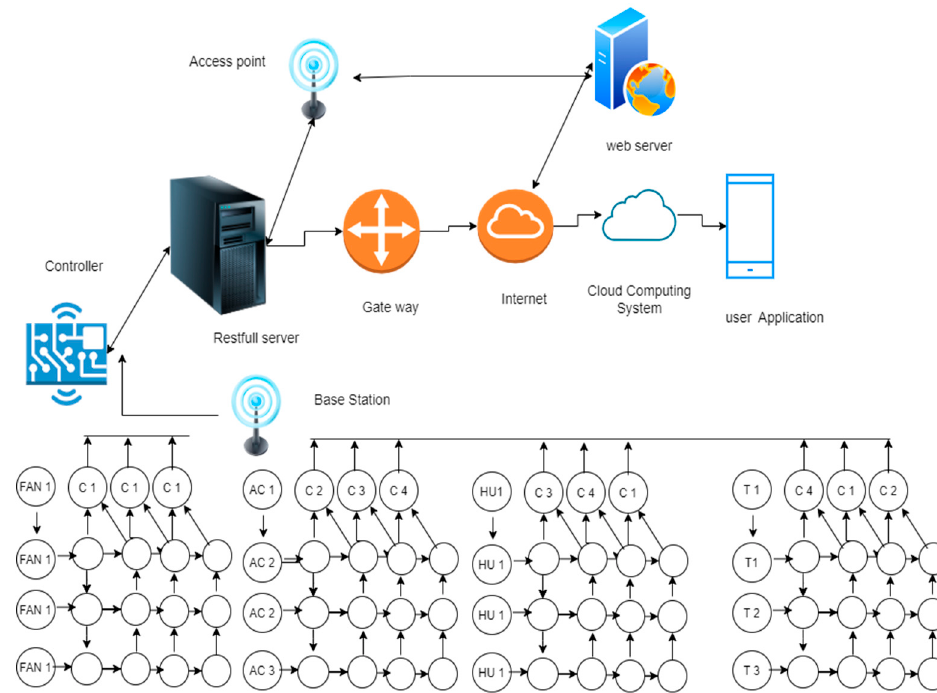
Figure 6. Revised IoT model through clustering in the device layer.